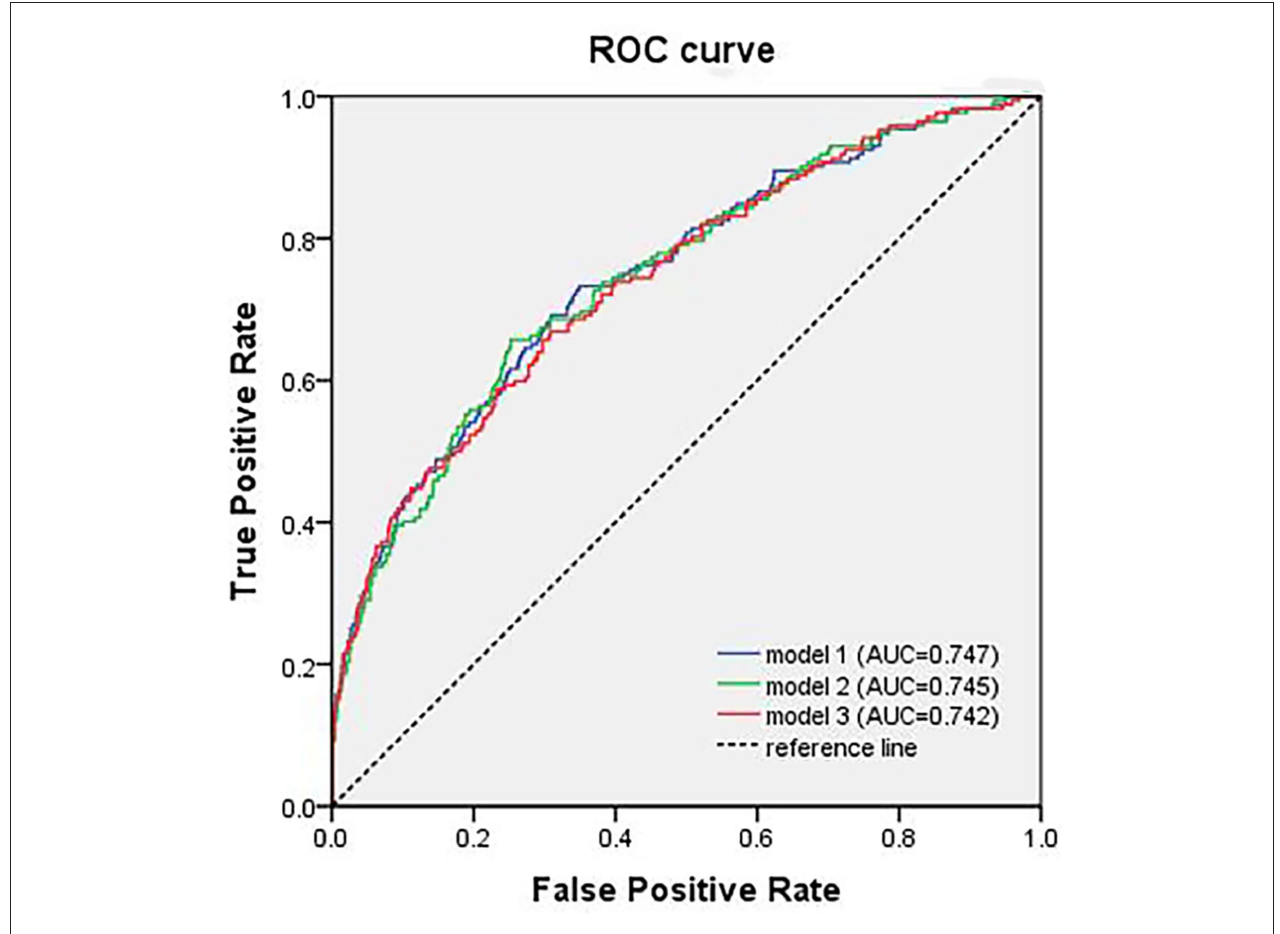
FIGURE 2 | The ROC curve analysis of different models of the logistic analysis. ROC, receiver operating characteristic; AUC, area under the curve.